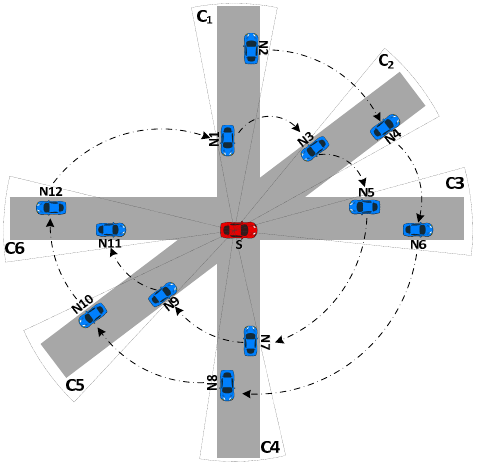
Figure 4. The sorting process for a priority list.